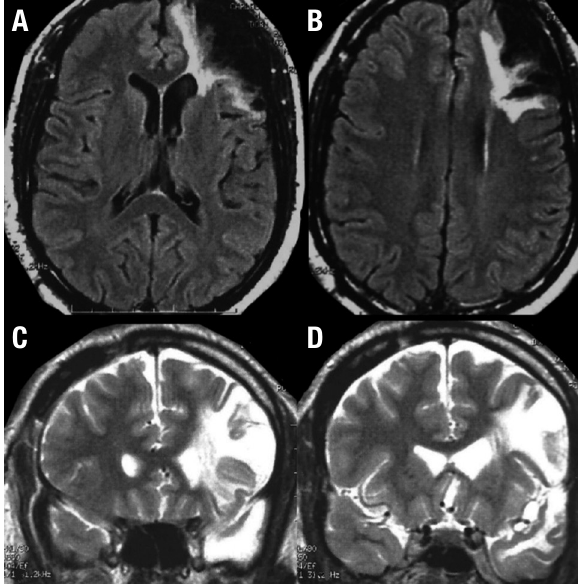
Figure 1. Brain MRI. [A, B] Axial FLAIR. [C, D] coronal T2WI. Reveals a large area of encephalomalacia and surrounding gliosis involving left frontal lobe. There is ex-vacuo dilatation of the left lateral